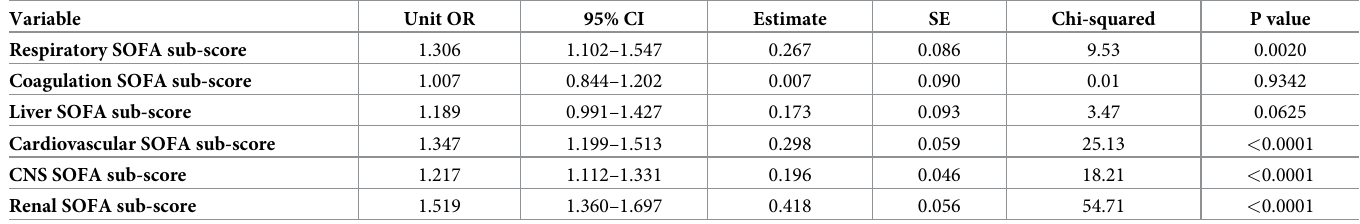
Table 3. Multivariate analysis of Day1 SOFA sub-scores as predictors of hospital mortality in primary study population using logistic regression. AUROC of the multivariate model was 0.738 for hospital mortality.